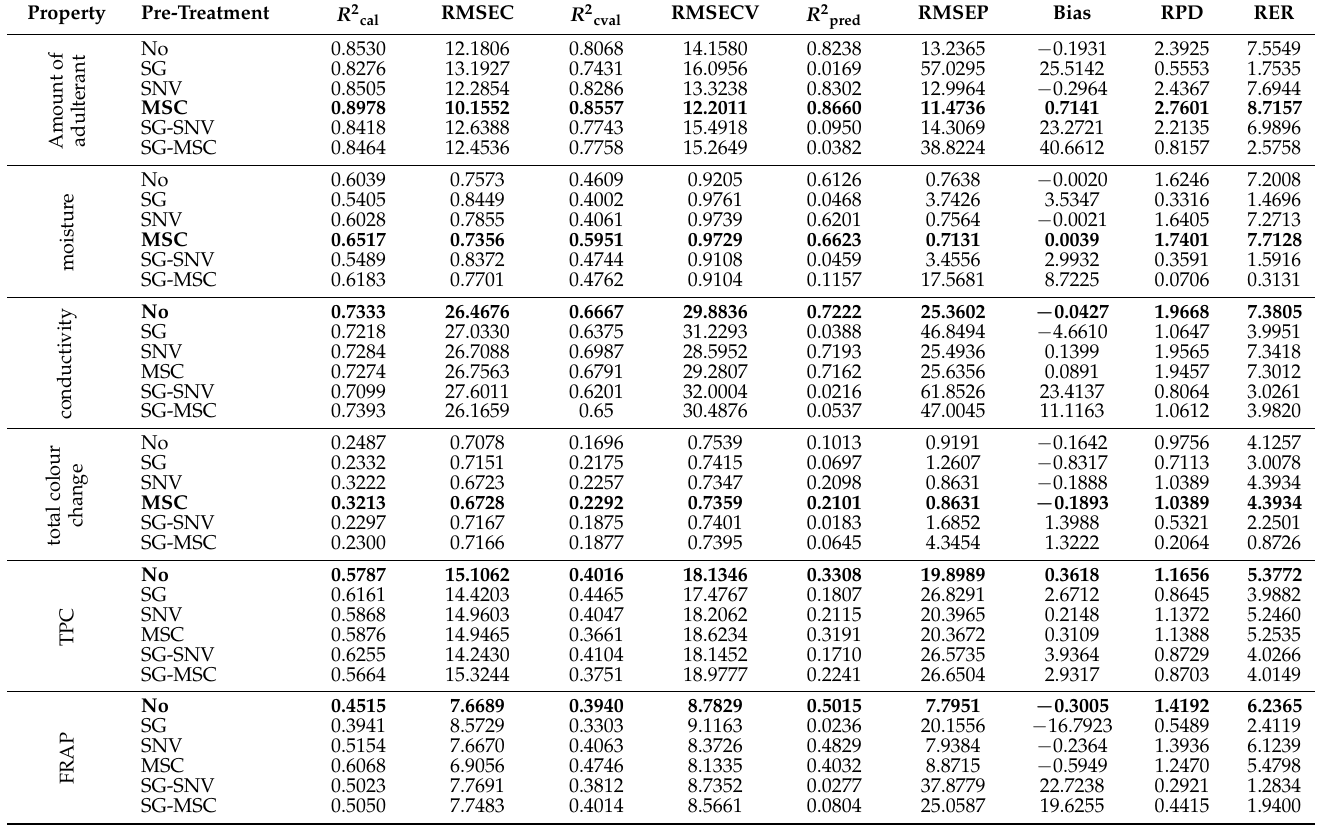
Table 1. Applicability of PLS models for prediction of honey adulteration and physical and chemical properties of pure honey samples and prepared glucose syrup adulterations based on different NIR spectra pre-treatments (selected PLS models are marked